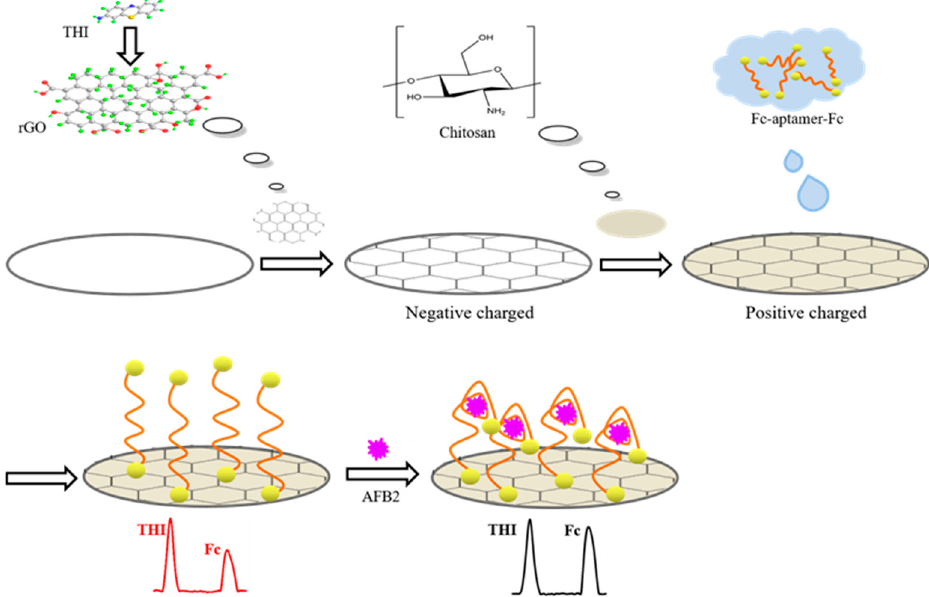
Scheme 1. Schematic illustration of the fabrication of a ratiometric aptasensor for AFB2